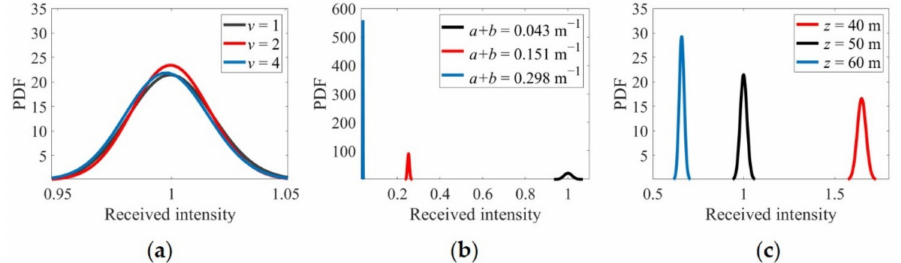
Figure 9. Simulated PDFs with different ( a ) flow velocities, ( b ) absorption and scattering coefficients, and ( c ) transmission